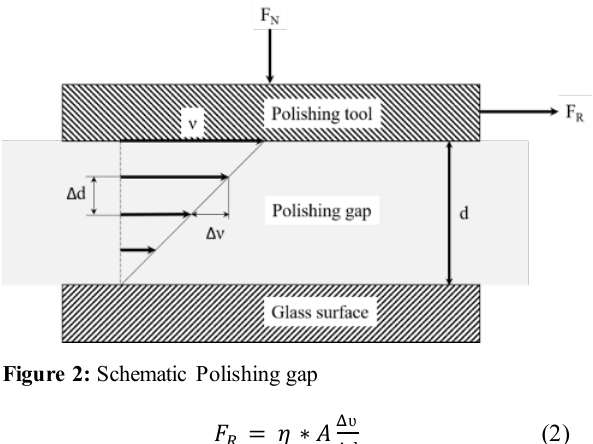
Figure 2: Schematic Polishing gap